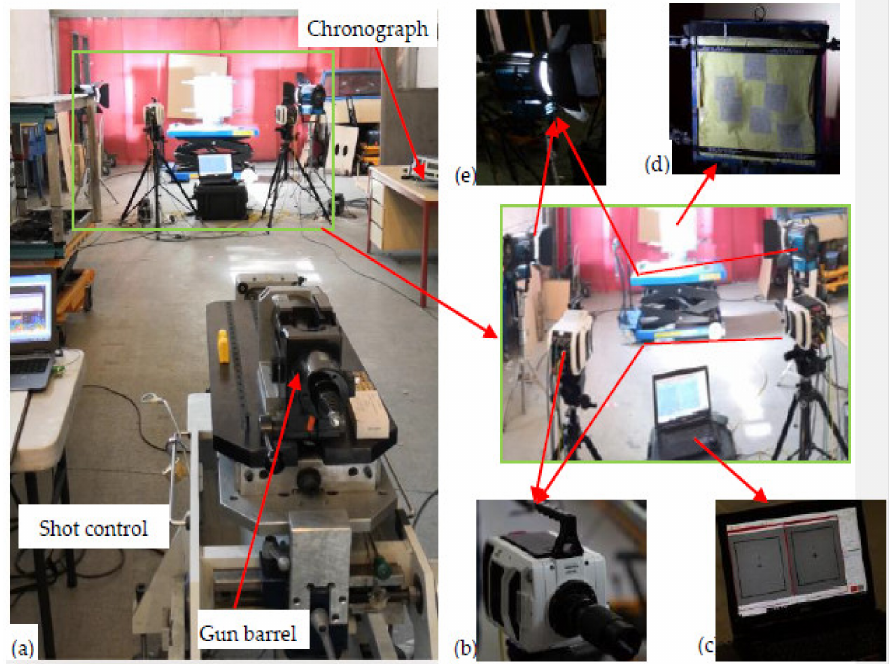
Figure 3. Ballistic testing facility: ( a ) the whole set-up, ( b ) high-speed camera, ( c ) computer system to synchronize the bullet and the high-speed camera recording, ( d ) armour panel system for testing and ( e ) high-voltage lighting